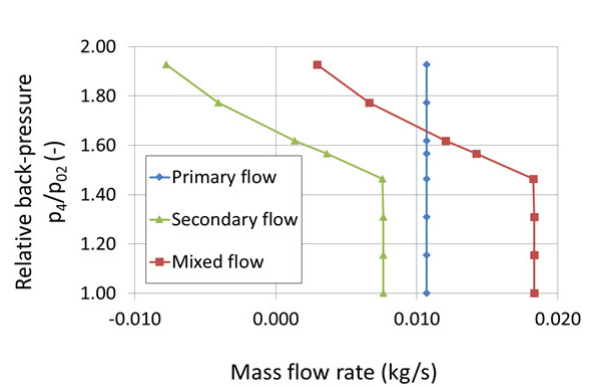
Fig. 5. Courses of the primary, secondary and mixed mass flow rate.